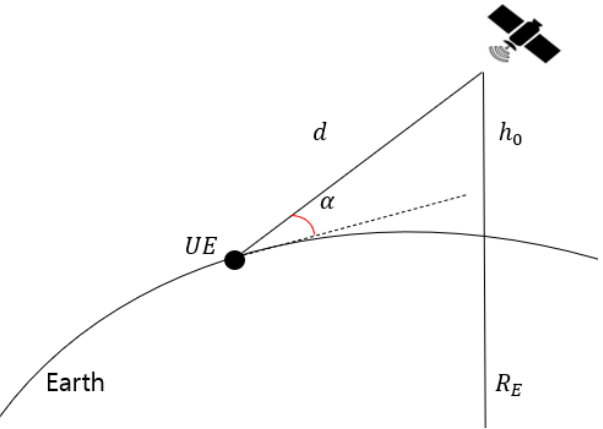
Figure 6. Slanted range d between a satellite and UE determined by R E , h 0 , and α .